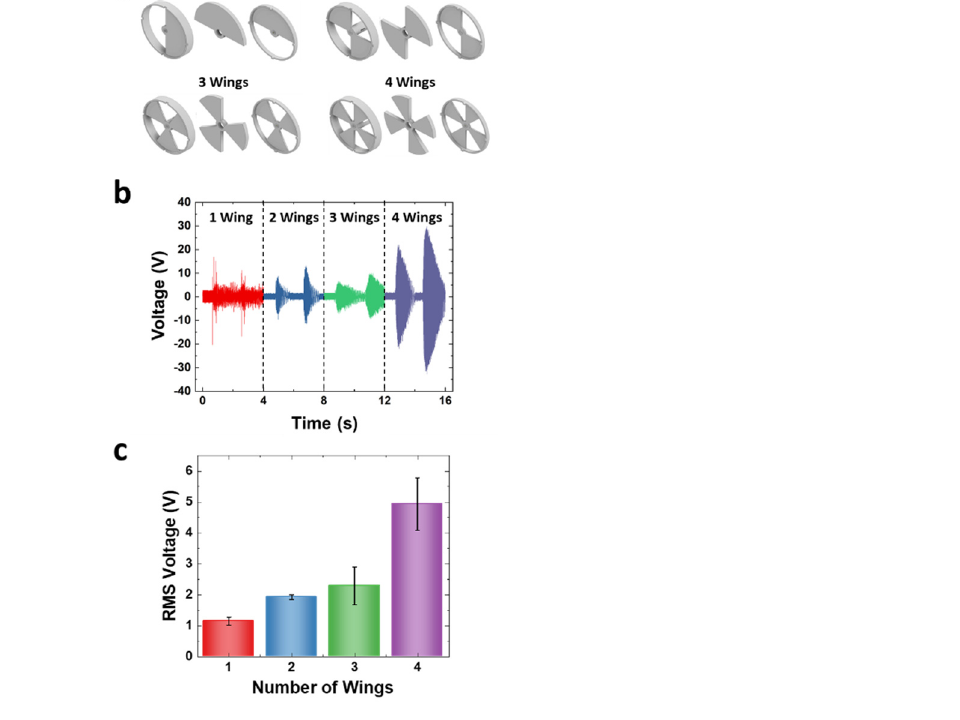
Figure 2. Electrical performance of the Y-TENG for different number of wings. ( a ) Schematic illustration of case-blade sets having 1, 2, 3, or 4 wings; ( b ) peak voltage and ( c ) root mean square (RMS) voltage output of the Y-TENG depending on the number of wings.